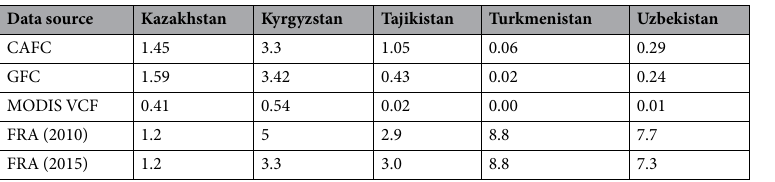
Table 1. Forest cover percentage (%) in Central Asian countries estimated from the Central Asia Forest Cover map (CAFC), Global Forest Change (GFC), MODIS VCF, and Forest Resources Assessments